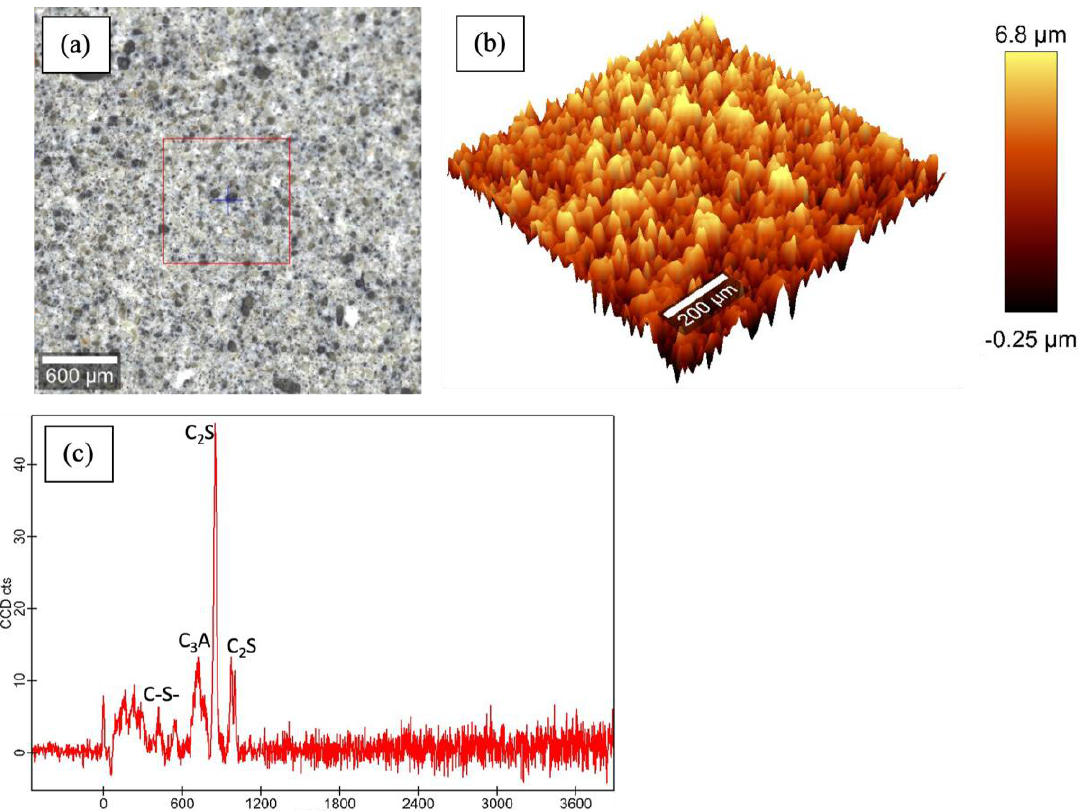
Figure 3. Raman results for polished cores of neat Class-H cement: ( a ) optical micrograph of polished cement core; ( b ) large-area profilometry scan of the cement; ( c ) phase peaks at 600–630 nm (C-S-H), 740 nm (C 3 A), 842 nm and 972 nm (C 2 S) were observed.